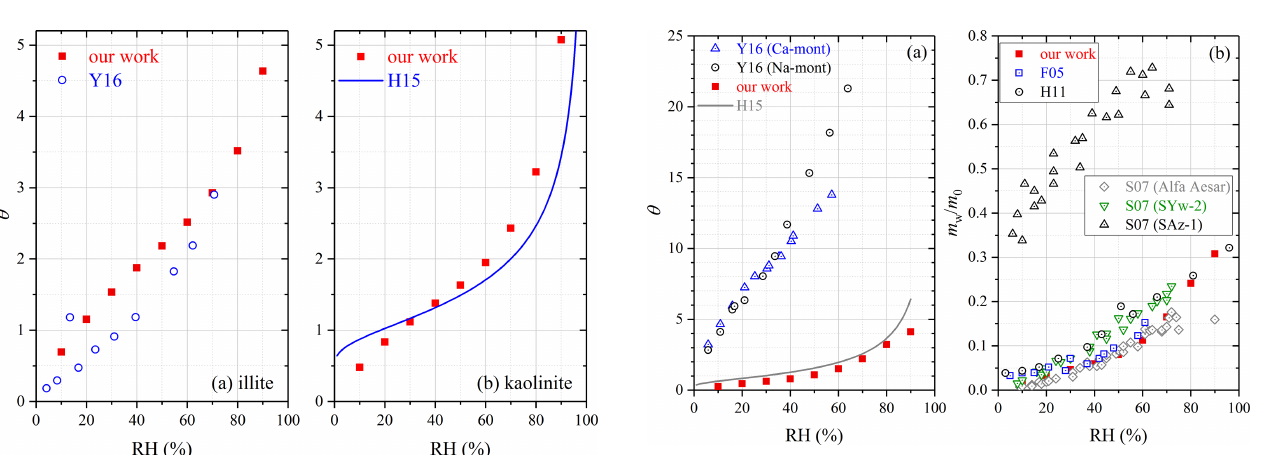
Figure 6. Comparison of surface coverages of adsorbed water ( θ ) measured by different studies for (a) illite and (b) kaolinite. H15, Hung et al. (2015); Y16, Ye¸silba¸s and Boily (2016).